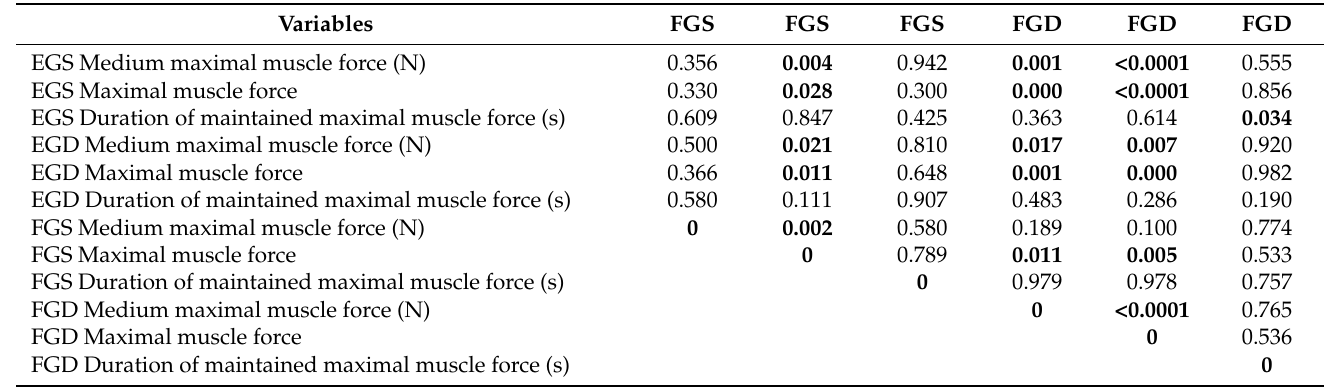
Table 19. p -values for Pearson correlation between muscle parameters of left and right knee extensors and flexors.